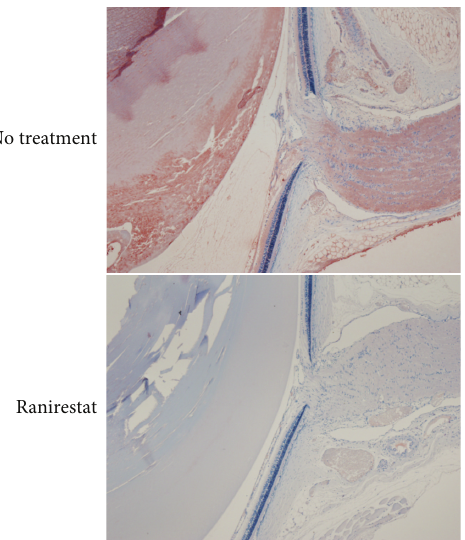
Figure 16: Immunostaining for CML (original magnification 4x) at 40 weeks. Immunostaining for CML shows severe staining in an untreated eye (top) compared with minimal staining in a ranirestat- treated eye